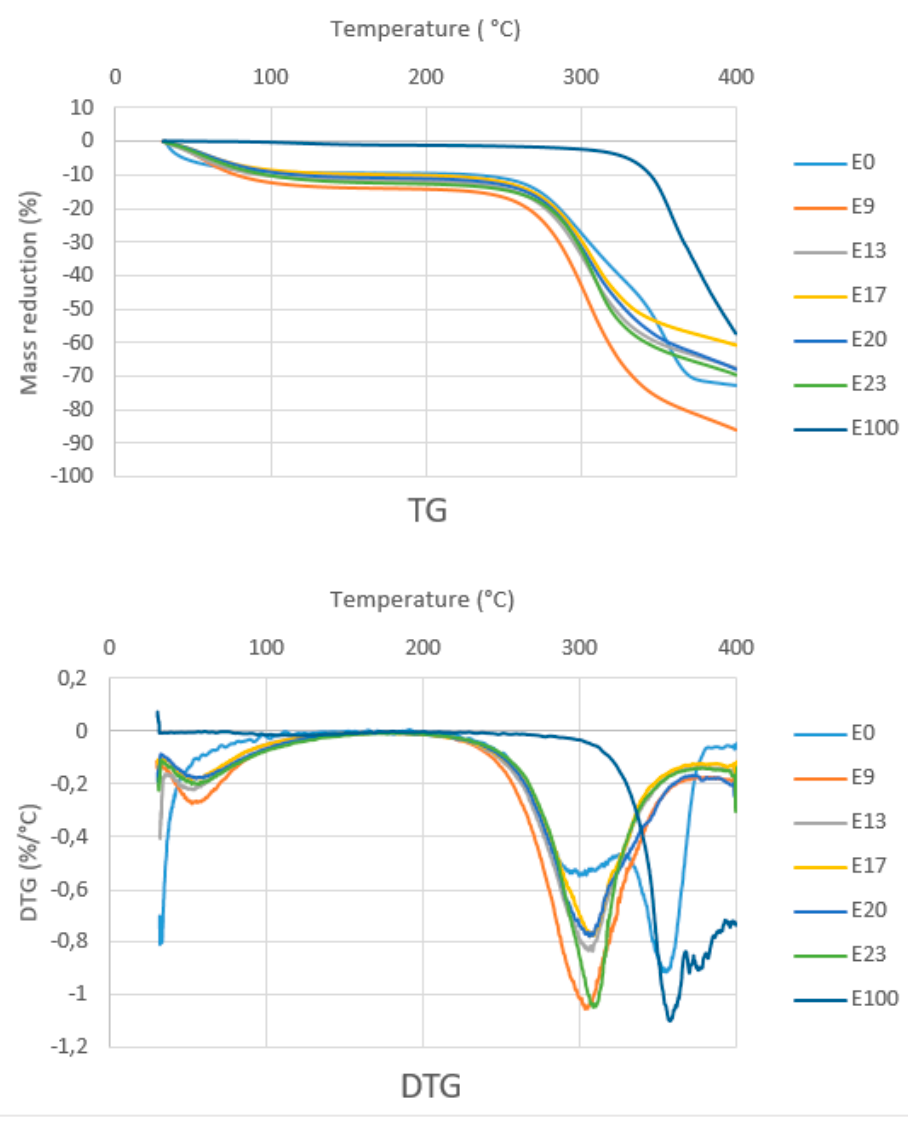
Table 2. Mass reduction and Peak points from TG curves.